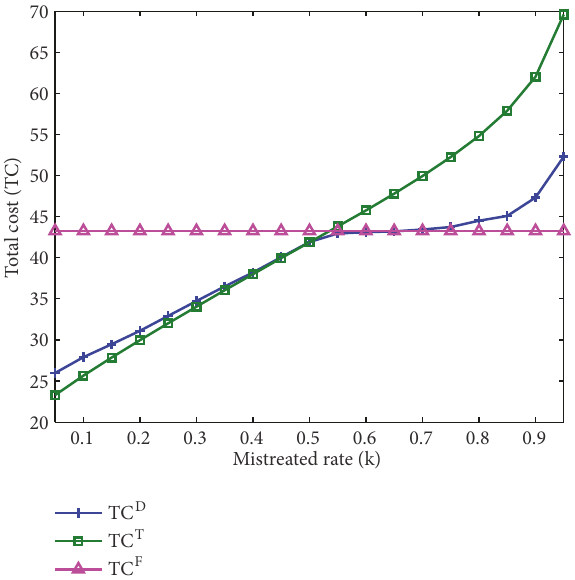
Figure 4: Impact of 𝑘 on the total costs of these